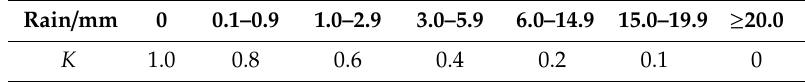
Table 1. The corresponding relationship between coefficient K and daily precipitation.